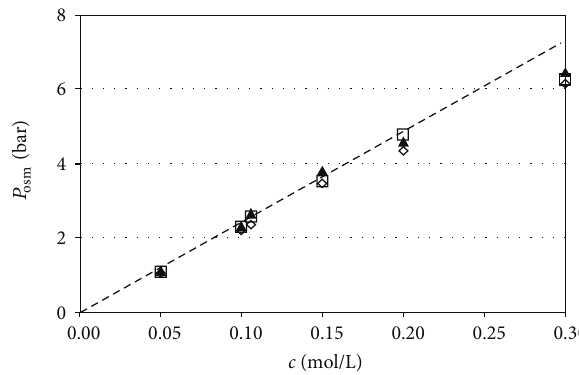
Figure 3: Comparison of equilibrium osmotic pressure values, 𝑃 as a function of solute concentration under regimes of constant and variable solution volume. Experimental data are from the readings of the electronic pressure sensor, respectively: ( ◻ ) constant solution volume; ( ◊ ) variable solution volume; ( 󳵳 ) variable solution volume (values corrected for dilution). The dotted line indicates the theoretical dependence (see